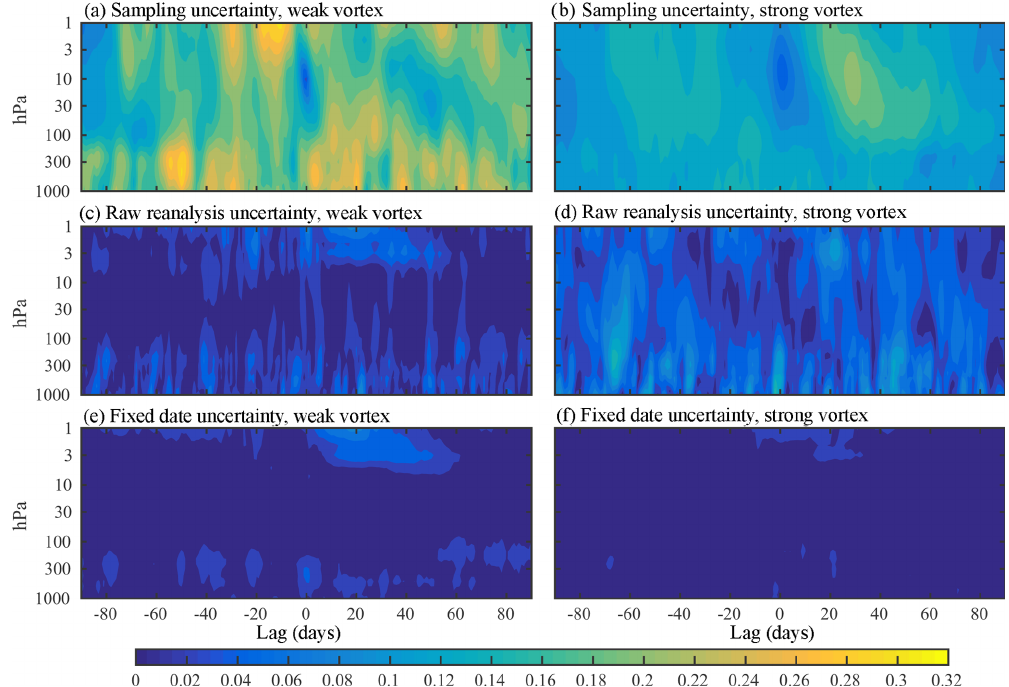
Figure 11. Three estimates of the uncertainty in the NAM index evolution around weak and strong events. Panels (a) and (b) show the sampling uncertainty in the mean weak or strong composites shown in Fig. 10a, b, expressed as a 1 standard deviation error bound. Panels (c) and (d) show a first estimate of the reanalysis uncertainty : the standard deviation between composites of weak or strong vortex composites based on the four modern reanalyses (ERA-Interim, JRA-55, MERRA2, and CFSR/CFSv2) over the period 1980–2016, where events are determined independently in each reanalysis. Panels (e) and (f) show a refined estimate of the reanalysis uncertainty: the standard deviation of weak or strong vortex composites based on the four modern reanalyses, but now using a standardized set of event dates. See the text for further